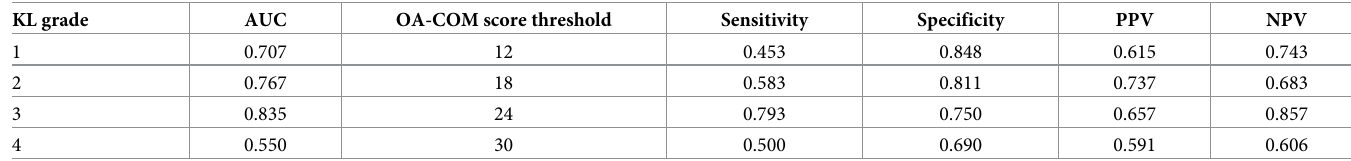
may be optimal for researchers familiar with the KL grading system. Specifically, that OA is a Table 4. Sensitivity, specificity, positive and negative predictive value (PPV and NPV) for selected cut points in the anchor point models. KL